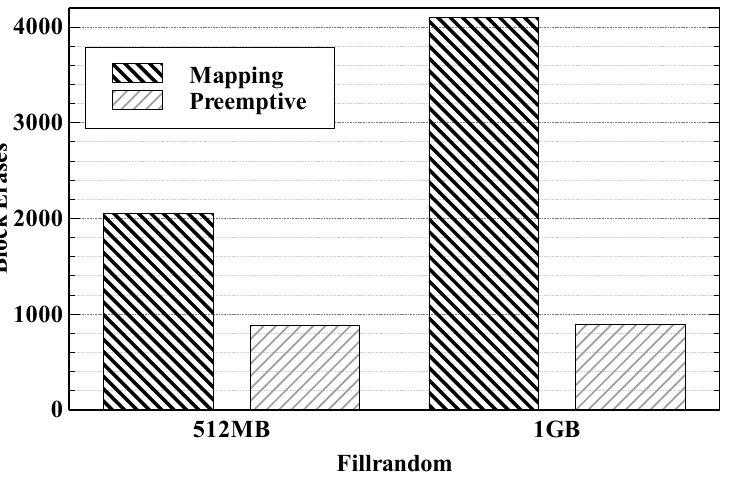
Figure 9. Total number of block erases performed during fillrandom with 464B values.